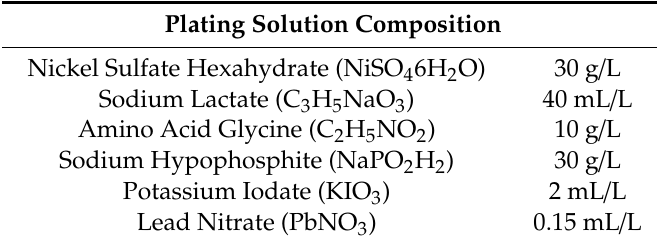
Table 1. Nickel–phosphorus alloy plating solution composition.